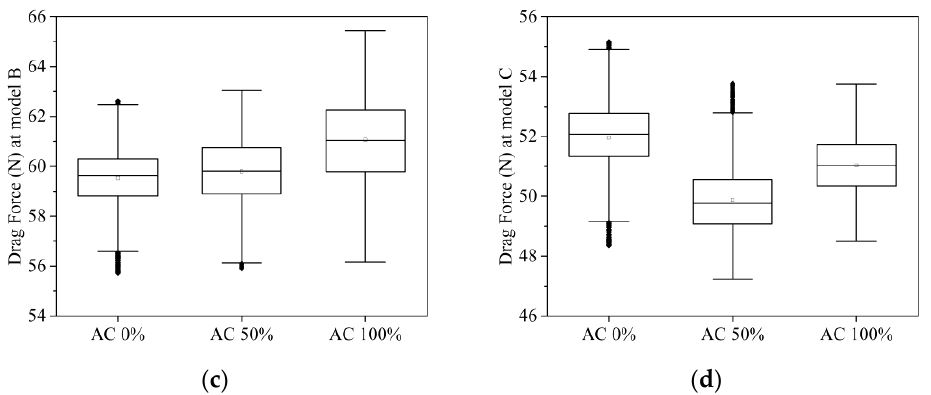
Figure 11. F X forces on ( a ) the front and rear of the bus; and ( b ) on the bus in model A; ( c ) model B; ( d ) model C.